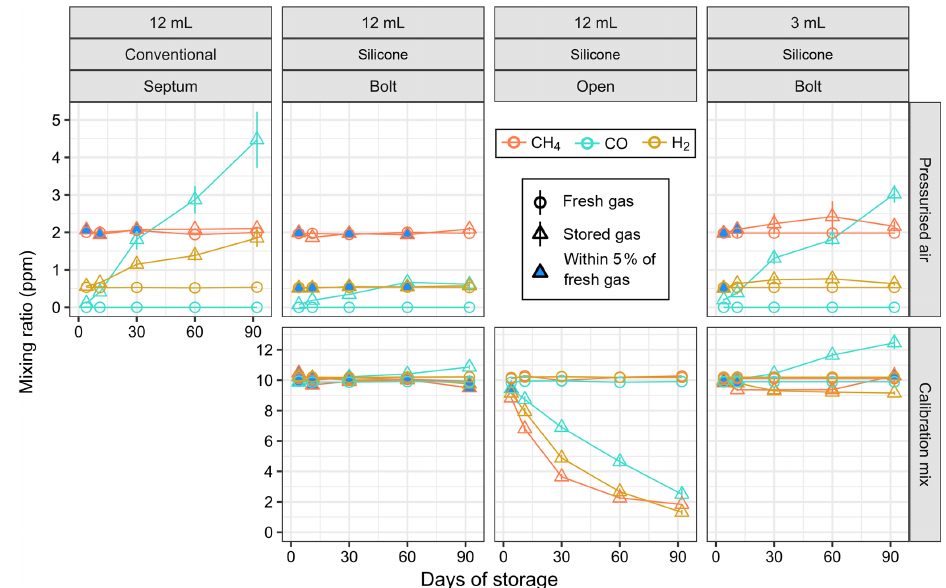
Figure 4. Measured mixing ratio of reference gases (pressurised air and calibration mix) freshly flushed from cylinder versus stored for up to 3 months in Exetainers with different seals. Error bars indicate standard error of the mean. The blue-filled shapes indicate that the difference between freshly flushed and stored gas is within 5% of fresh gas. Note that carbon monoxide (CO) was not detected in fresh pressurised air and that the mixing ratio is plotted as